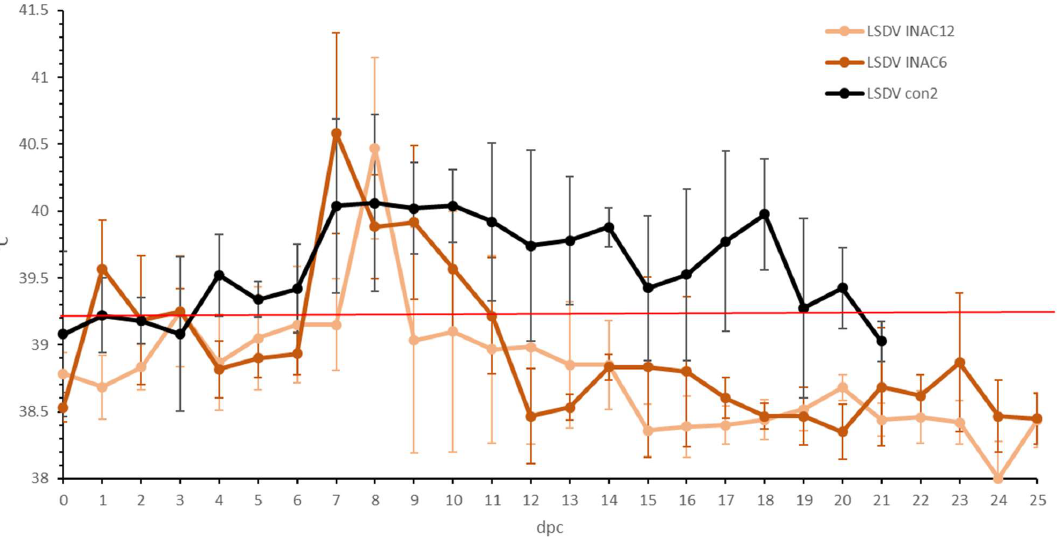
Figure 6. Averaged body temperatures of the LSDV Inac groups after challenge. For comparative purposes: the average of the control group LSDV con2 was added, Solid line: fever cut-off for consecutive days; standard deviation is shown as error bars.